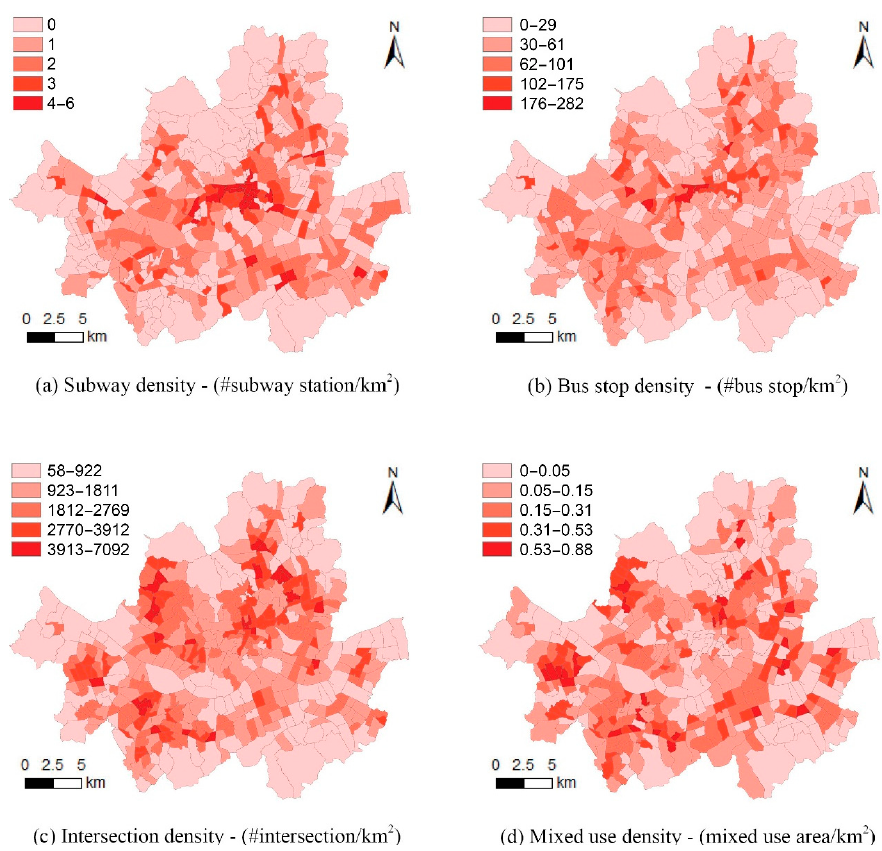
Figure 3. The present condition of the walkability